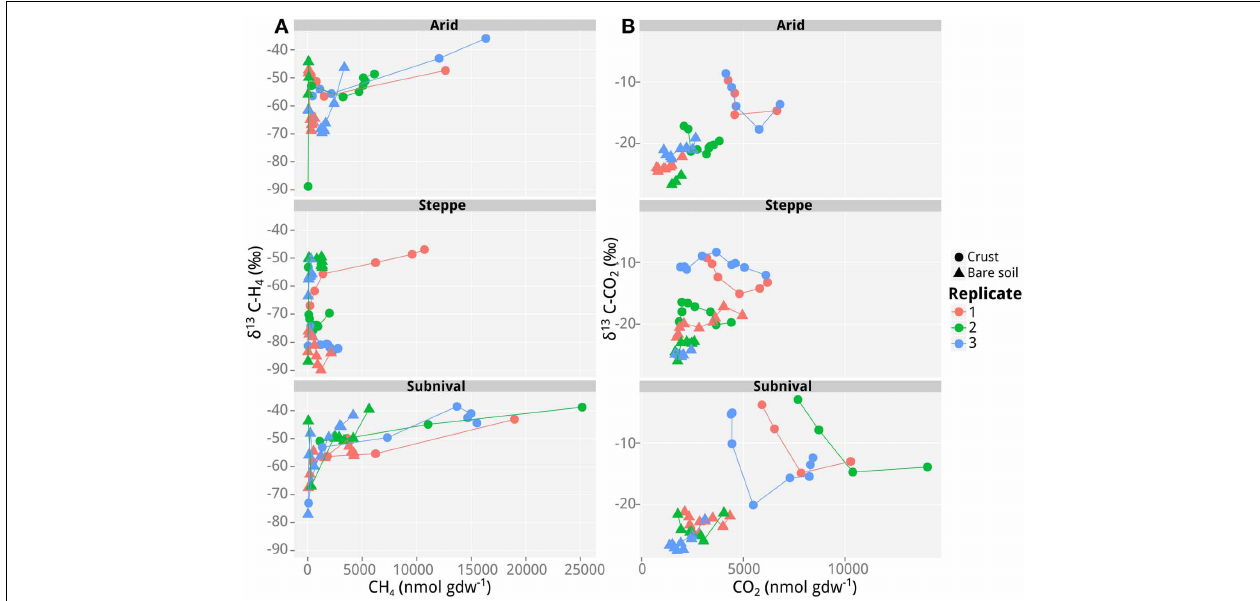
FIGURE 1 | Values of δ 13 C of CH 4 and CO 2 as a function of CH 4 and CO 2 concentrations in incubations with soil samples from the different vegetation belts in Tsomoriri Plains. Depicted are the three vegetation belts samples: arid, steppe, and subnival. (A) δ 13 C of CH 4 and (B) δ 13 C of